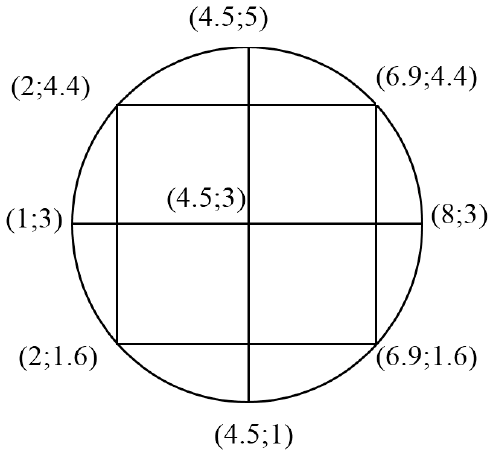
Scheme 1. DoE for each enzyme. Table 1. Treatment conditions (for each enzyme) for the first DoE. Test Number Time (h) Enzyme Concentration (%